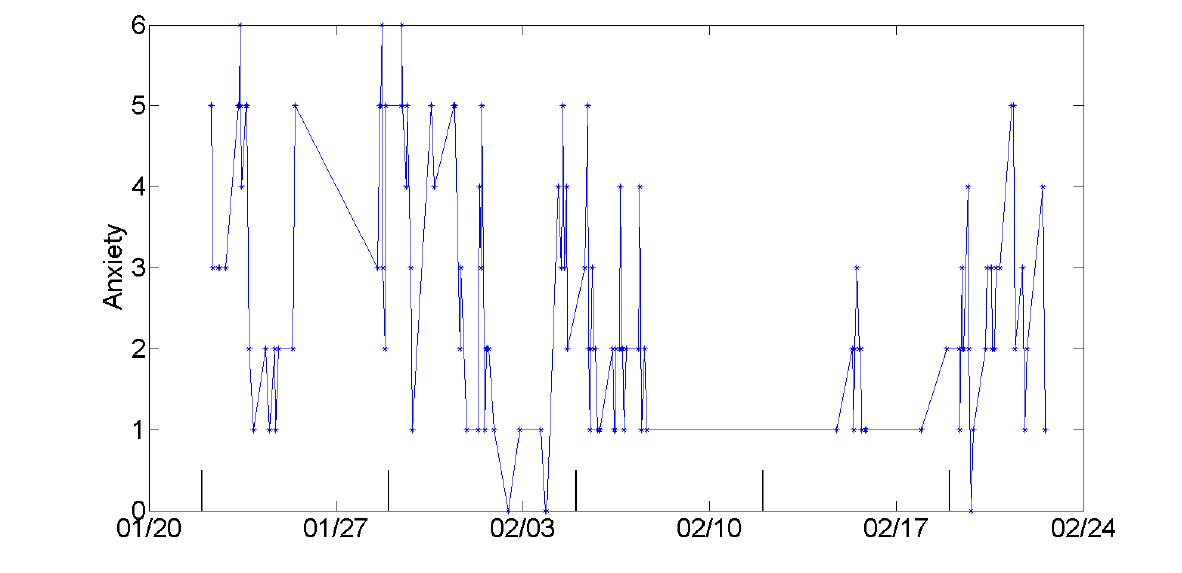
Figure 13. This time series visualization shows Octavia’s lowered anxiety ratings in weeks three and four of the study, a pattern that matches her interview account of decreased anxiety. The short vertical lines along the x-axis mark the beginning of each week in the